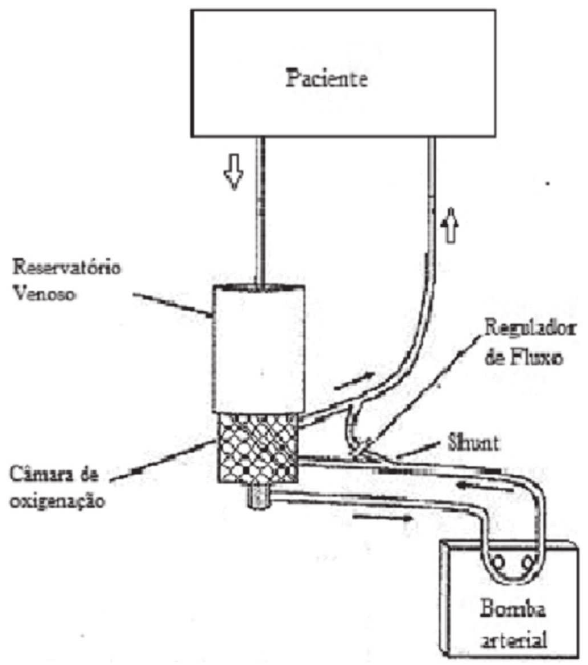
Fig. 1 - Representação esquemática do circuito de CEC com shunt